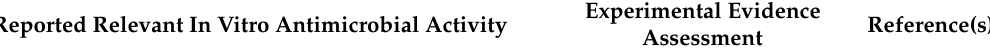
Table 2. Some South African medicinal plants and compounds with potential in treating sexually transmitted and related